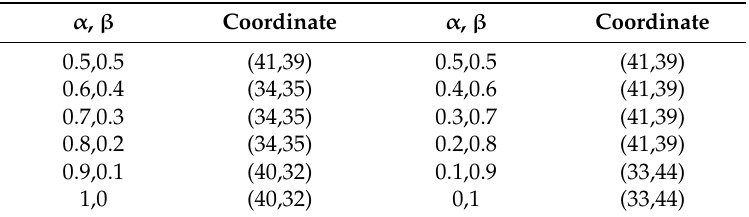
Table 3. Proportions of distance priority α and routing hop priority β .